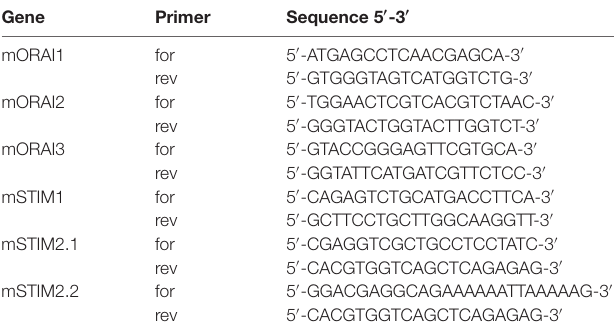
TABLE 1 | Primers for real-time polymerase chain reaction (PCR) for store-operated calcium entry (SOCE)